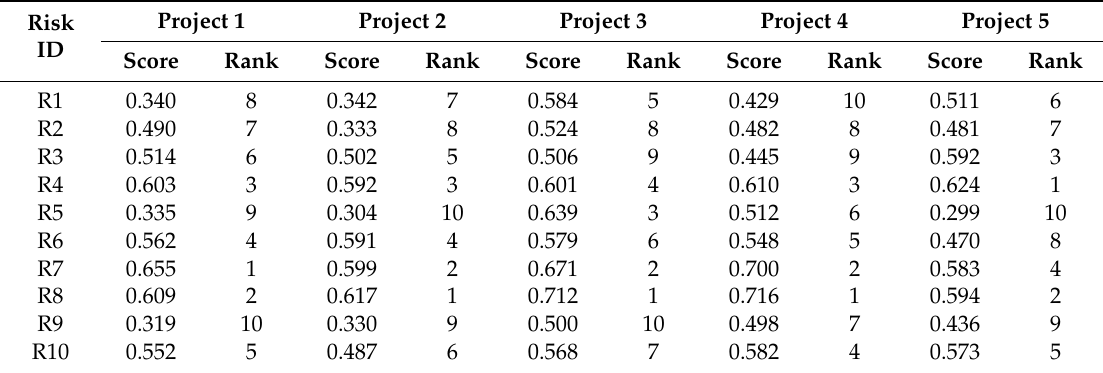
Table 10. The results of fuzzy technique for order of preference by similarity to ideal solution (FTOPSIS) output and ranking the risks in 5 investment projects.